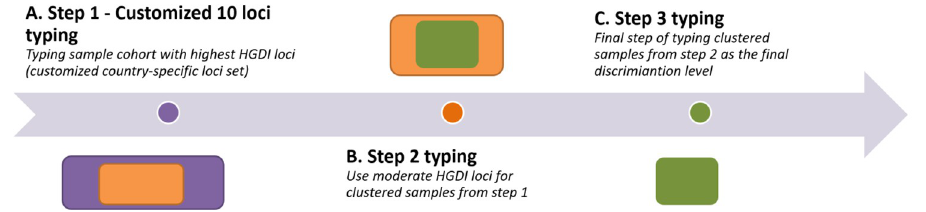
Fig 1. Schematic representation of the MIRU-VNTR stepwise approach. Schematic representation of the stepwise approach, with reduced amount of the samples to be typed after application of each step of locus group, resulting reduced time, cost and